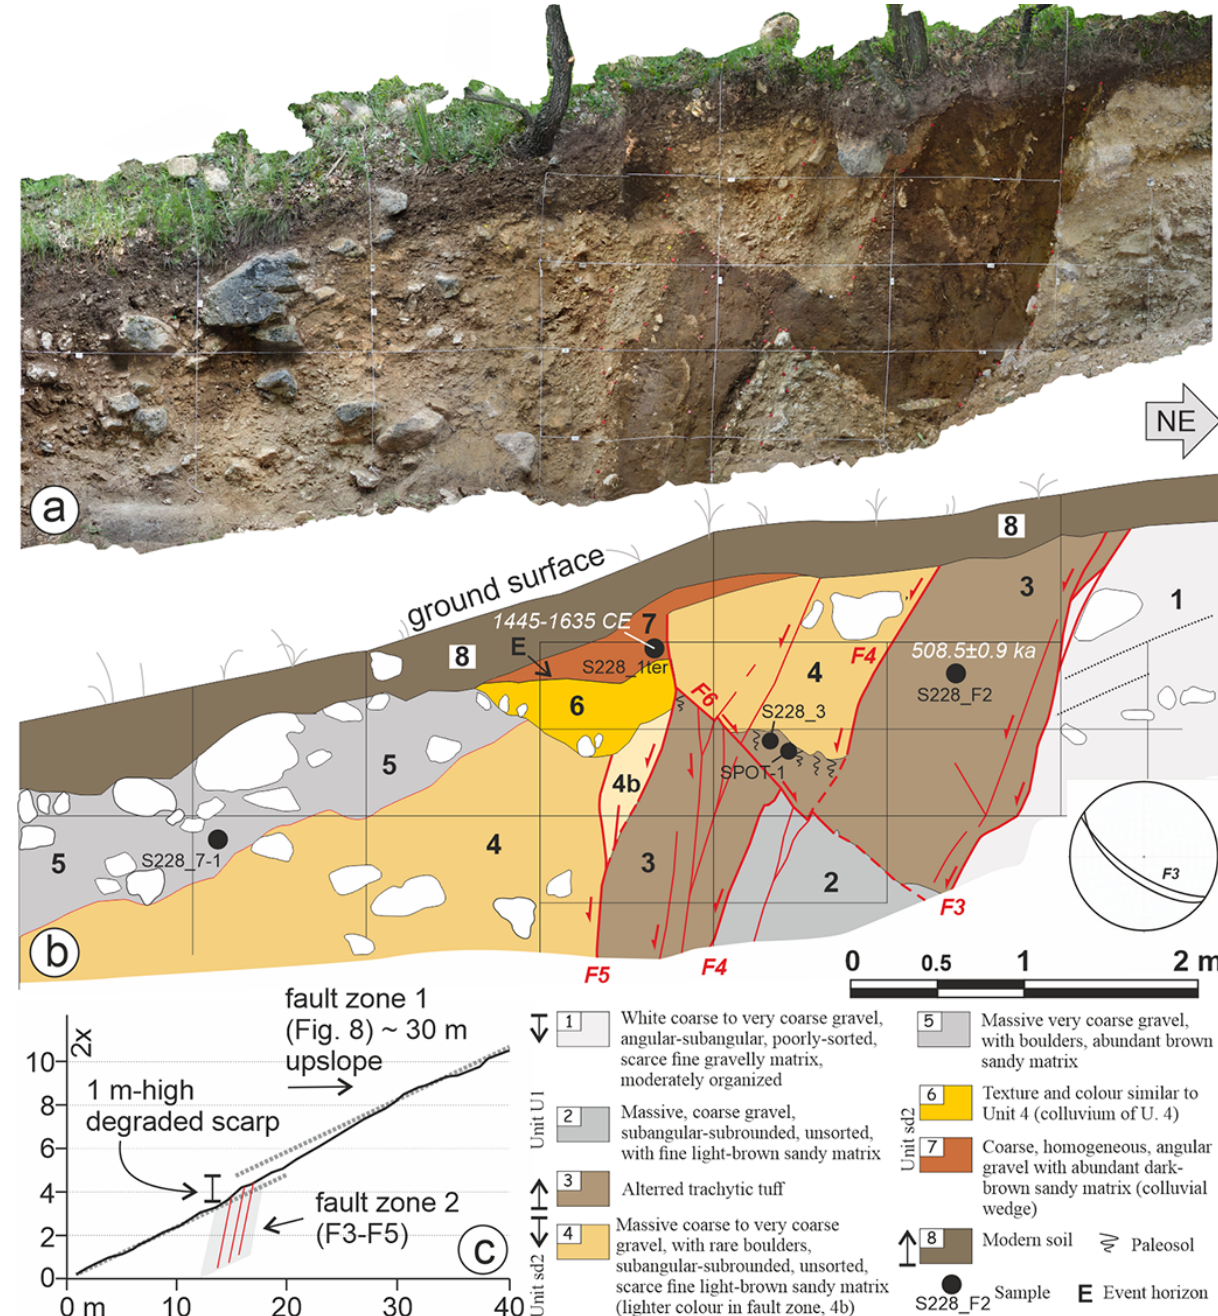
Figure 9. Photomosaic (a) and interpreted log (b) of fault zone 2 and micro-topographic profile (c) across the fault zone in the western splay of the Gioia Sannitica normal fault (San Potito fault section, central part; location shown in Figs. 2b and 4). Unit numbering (1 to 8) refers only to this outcrop (units do not necessarily correlate with other units with the same number in Figs. 8 and 10); the stratigraphic position of units U1 and sd2 is indicated in Fig. 3. Event horizon (E) refers to the topographic surface at the time of the last surface faulting event. The complete details of the age determinations are given in Tables 1, 2, and S1. Detailed analysis of the paleosol (sample S228_3 and SPOT-1) is given in Text S1. Photographic details of the fault zone; a restoration of displacements on faults F4, F5, and F6; and a possible restoration of the last two surface faulting events are reported in Figs. S2, S3, and S4, respectively.